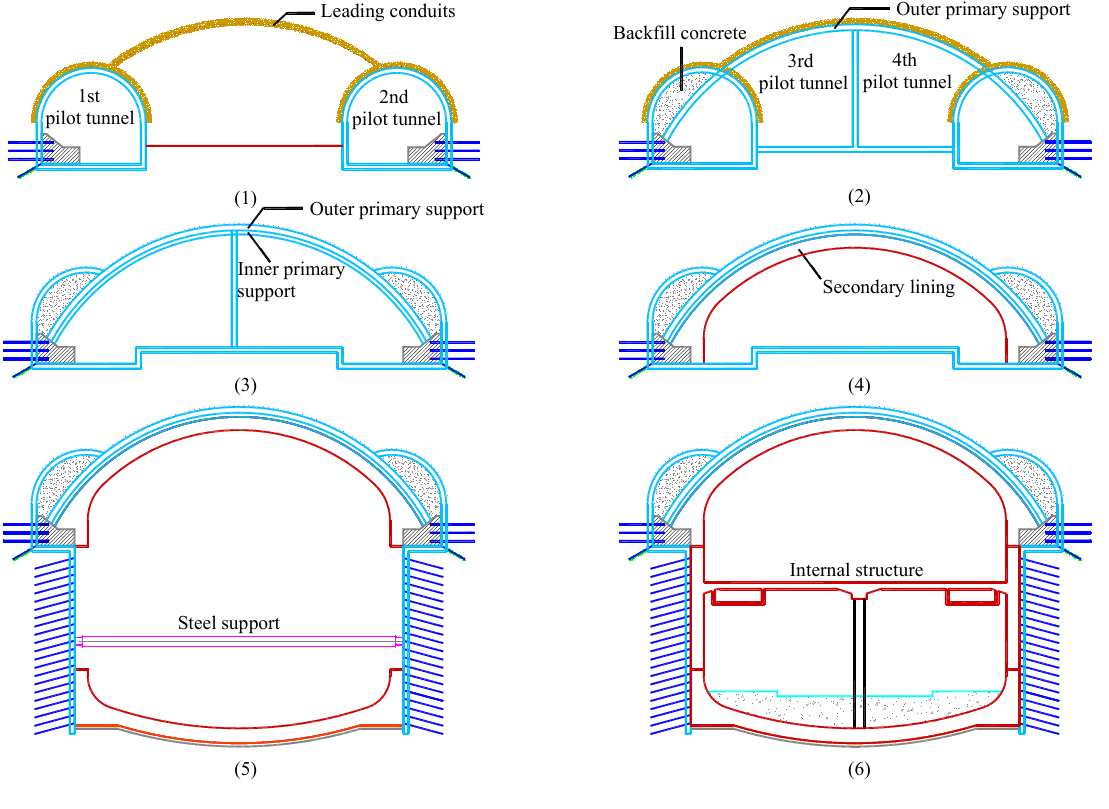
Figure 3. Construction sequences of the arch cover method.